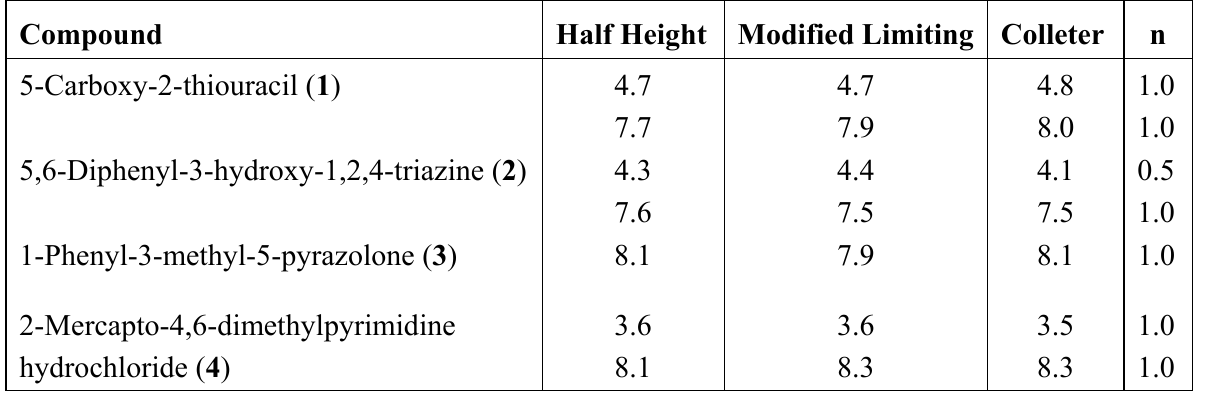
Table 1: Dissociation Constants (pKa) of the Organic Compounds at λ = 335